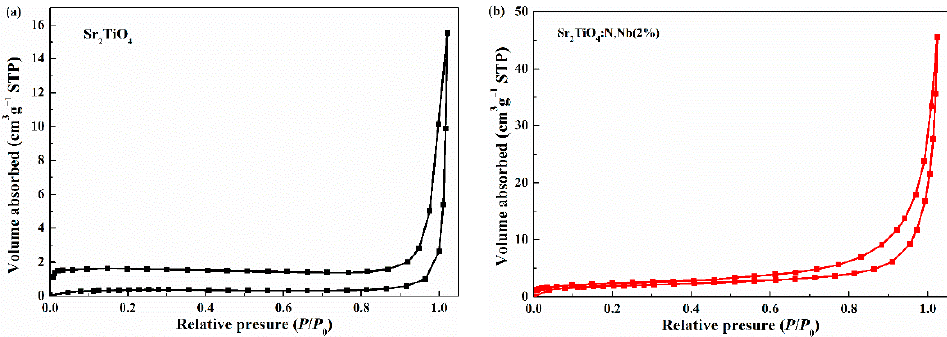
Figure 8. N 2 adsorption/desorption isotherms Sr 2 TiO 4 ( a ) and Sr 2 TiO 4 :N,Nb(2%) ( b ).